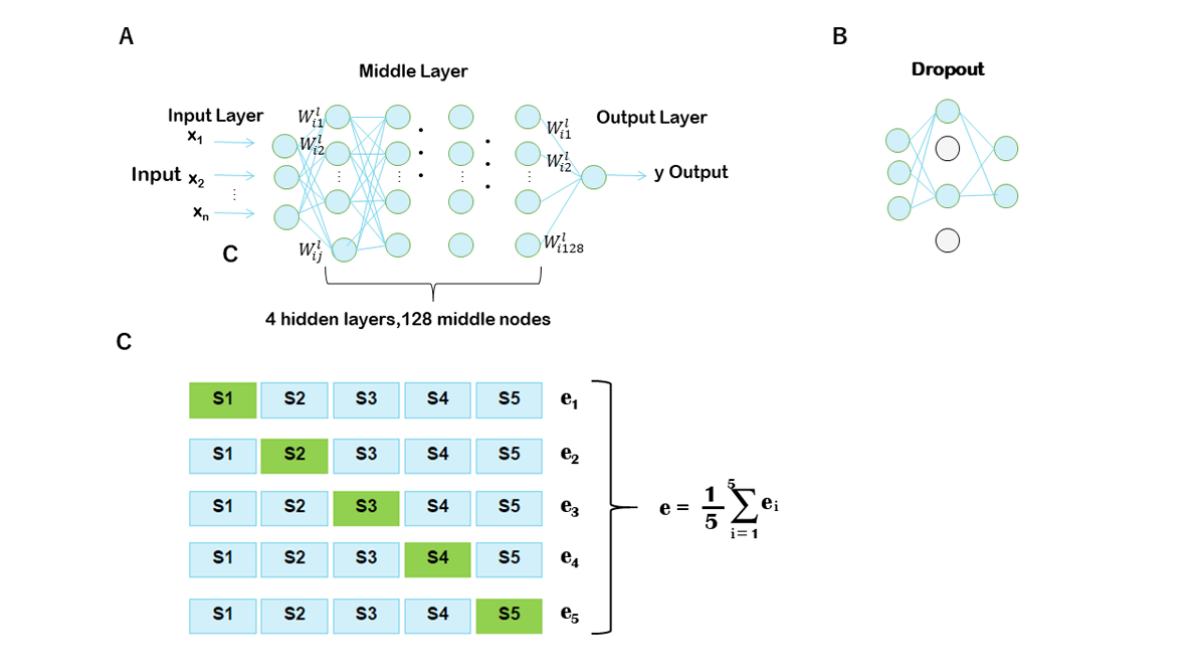
Figure 1. (A) Schematic diagram of our neural network models: X=(x1,…, xn) is the input vector and Y=y is the element of the output layer; Wlij is the weight between the ith neuron of the (l)th layer and the jth neuron of the (l-1)th layer . (B) Schematic diagram of dropouts. (C) Schematic diagram of 5-fold cross-validation; S1-S5 indicates data subsets 1 to